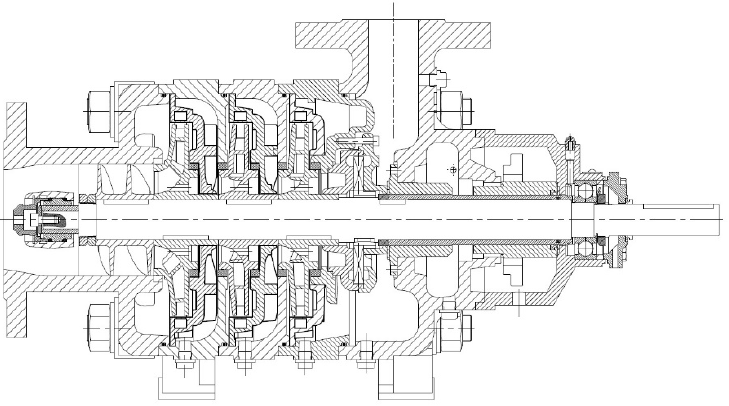
Figure 1. Cross-section through a multistage centrifugal pump (http://www.pumps-hv.com/multi-